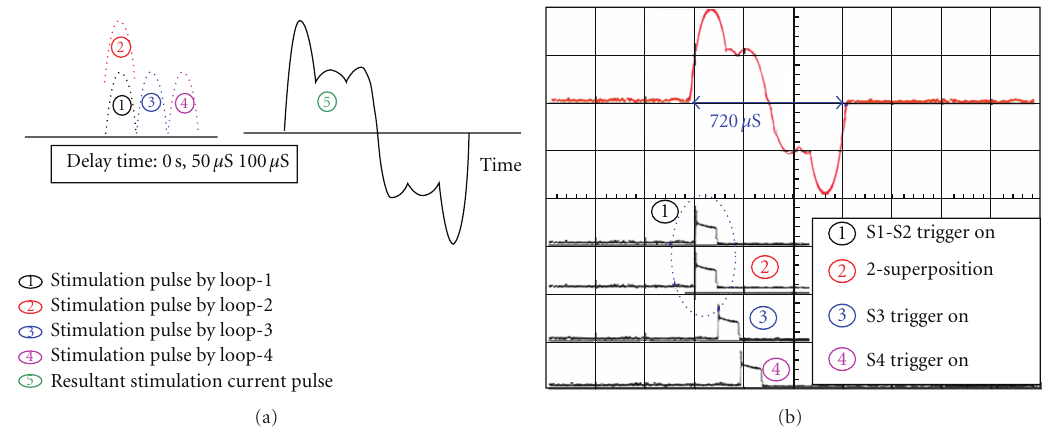
Figure 4: (a) Idea, (b) test. S1, S2 → S3 → S4: trigger on (delay: 0s, 50 μ S, 100 μ S; pulse width: 720 μ S).